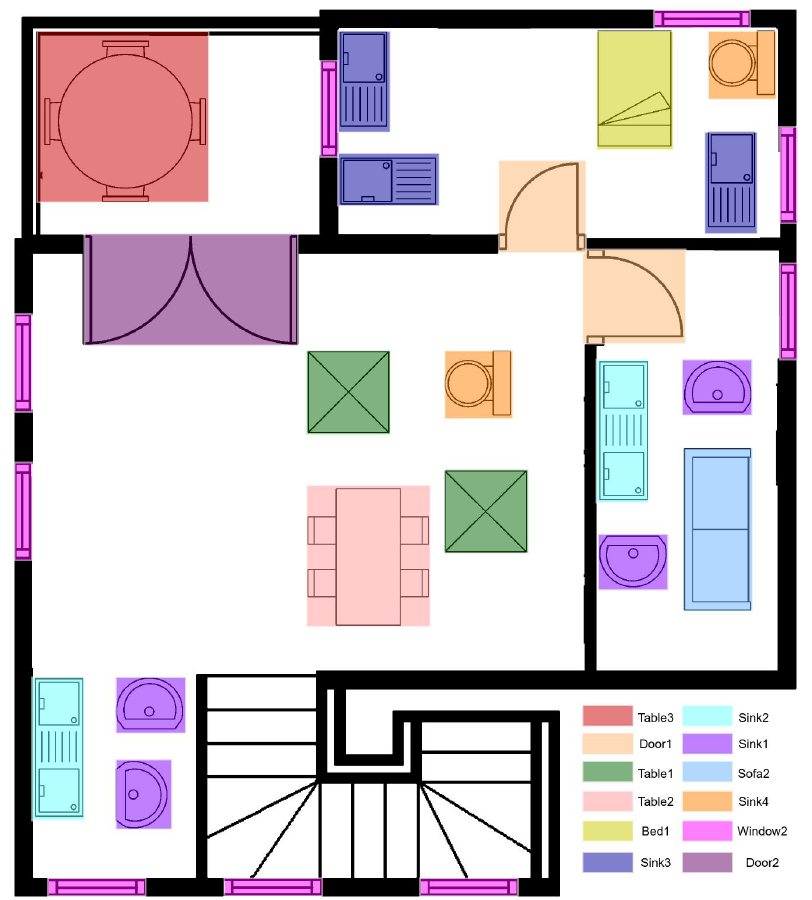
Figure 1. The sample image of the floor-plan dataset containing furniture items. The bottom right corner of the image shows labels of furniture